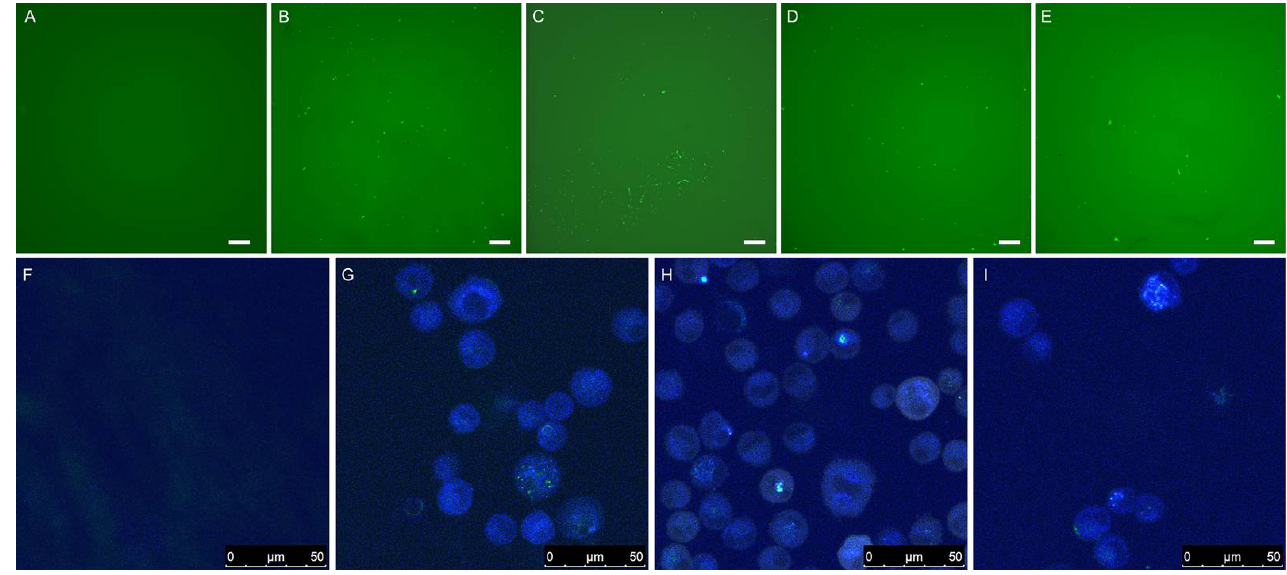
Figure 7. The top five images were taken with a fluorescence microscope at 40× magnification and show A549 cells 48 h post transfection with pdsAAV-CB-eGFP. The white scale bar in the bottom right corner indicates 200 µm. ( A ) Plasmid DNA control; ( B ) PEI + DNA; ( C ) SWCNTs + DNA; ( D ) PLL-coated birch LNPs (286 nm diameter) + DNA; ( E ) PLL-coated wheat LNPs (282 nm diameter) + DNA. The bottom four images were taken with a confocal microscope and show the results from a separate transfection experiment. ( F ) Plasmid DNA control; ( G ) Functionalized single-walled carbon nanotubes + DNA; ( H ) PLL-coated birch LNPs (286 nm diameter); ( I ) PLL-coated wheat LNPs (282 nm diameter) + DNA. Scan speed was 400 Hz, numerical aperture was 1.4 and the laser was 405 nm diode UV. The scale bar in the bottom right corner indicates the size.